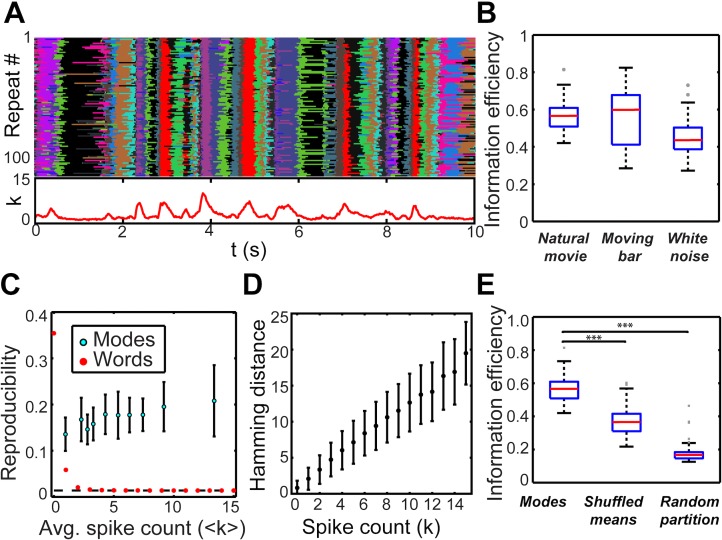
Mode reproducibility across stimulus repeats.(A) Top: Mode activation over 108 identical 10 sec repeats of a moving bar stimulus. This dataset included 140 cells and 30 modes. Each color corresponds to a distinct mode; black is the silent mode. Bottom: Population spike count averaged over the repeats. Note that reproducibility was generally high, dropping for low k and during transitions between modes. (B) Information efficiency of mode activation across repeats of the same stimulus (Information efficiency = mutual information about stimulus / mode output entropy; see Methods), for three distinct stimulus classes. Box plots depict the distribution of this quantity over all modes. Red line = median; blue box = 25% (lower) / 75% (upper) percentiles; black lines = minimum (lower) and maximum (upper), excluding outliers; gray points = outliers. Natural movie: 170 cells, 100 modes, 73 repeats. Moving bar: same data as (A); 140 cells, 30 modes, 108 repeats. White noise (used in Fig 10): 155 cells, 50 modes, 69 repeats. (C) Reproducibility of modes or words across stimulus repeats, defined as the fraction of repeats (out of 73) on which the mode or word occurred within 80 ms of an occurrence at a different repeat, averaged over all times when the mode or word occurred at least once. Reproducibility of the mode response increased slightly with activity level, while that of words dropped to the minimal possible reproducibility (dashed line). For modes, data points were averaged over bins; error bars: ±1 standard deviation. For words, all words sharing the given k value were averaged. (D) Hamming distance between pairs of words occurring at the same time across identical stimulus repeats, averaged over pairs. Error bars: ±1 standard deviation. (E) Box plot of mode information efficiency compared to randomized controls. The true modes were significantly more reproducible than either control (***: p < 0.001; Mann-Whitney U test).